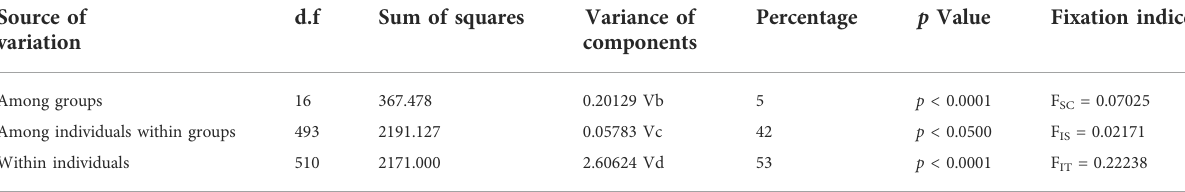
TABLE 4 AMOVA test of all 17 Ae. albopictus populations collected from different regions of Nanjing, China. Source of